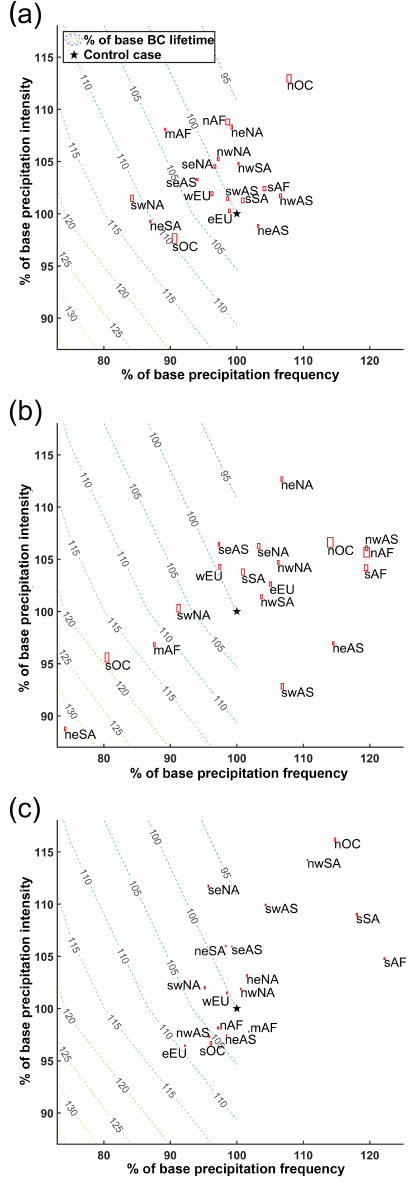
Figure 5. The potential change of atmospheric BC aerosol lifetime driven by the changes between the two periods (2001–2010 and 1981–1990) in precipitation characteristics based on multiple me- teorological datasets: (a) NCEP, (b) NCEP2, and (c) MERRA. The dashed contours are the same as in Fig. 2, which indicate the atmo- spheric lifetimes of the black carbon aerosols from the interpolation of 20 cases and show the potential changes of BC lifetimes from the base BC lifetime (in the control run) driven by the changes of pre- cipitation intensity and frequency. Red blocks show the changes of precipitation intensities and frequencies, with the size of the block showing the standard error of the percentage